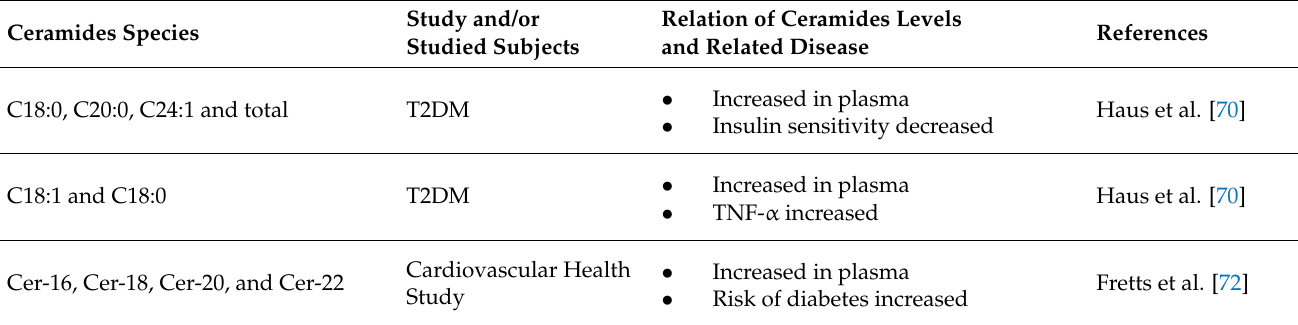
Table 3. Ceramides species evaluated in insulin-resistance and type 2 diabetes